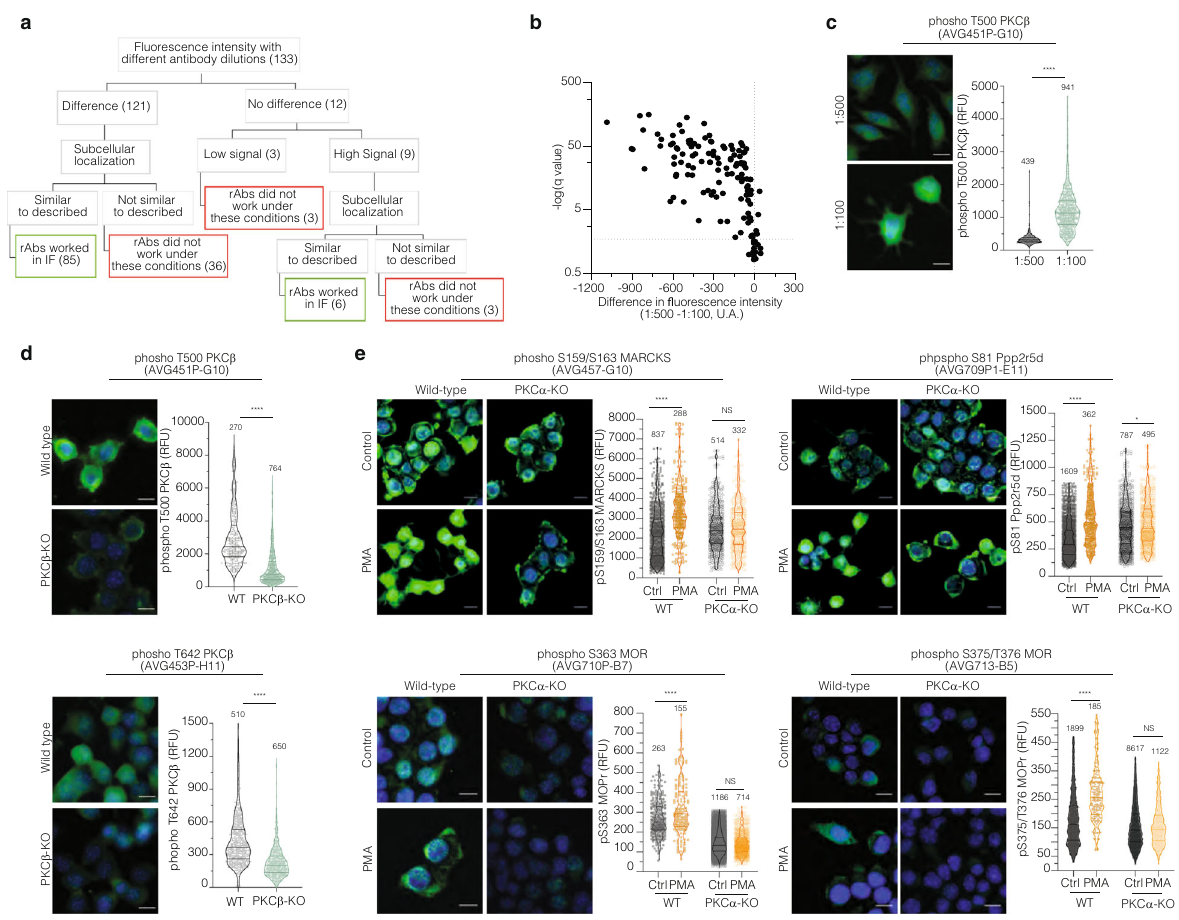
Fig. 3 High-throughput microscopy and genome editing as strategies to validate rAbs. a Schematic representation of the criteria used to validate the antibodies by high-throughput microscopy. The number of antibodies that matches each criteria step is represented in the box. b Volcano plot representing the fl uorescence intensity difference obtained from the comparison of two rAbs dilutions. Each dot represents one antibody tested. The x -axis describes the difference in the antibody fl uorescence intensity at two different dilutions (1:500 – 1:100), and the y -axis describes the log of the desired False Discovery Rate (Q). Using GraphPad prism, the two-stage step-up method of Benjamini et al. 13 was used to perform the analysis. The antibodies with Q higher than 2% were considered signi fi cant. c Representative image of Neuro2A cells probed with anti-phospho T500 PKC β (AVG451P-G10) antibody at a dilution of 1:500 and 1:100 (green), and DAPI (blue). Images were acquired using the InCell microscope (×40) and fl uorescence intensity measured by Cell Pro fi ler software. Representative images with the antibody staining in green and DAPI in blue are shown. Volcano plot, each dot represents one cell. Lines are mean ± SD of two experiments, number of counted cells are indicated. RFU indicates the integrated fl uorescence intensity units. **** p value < 0.0001; t -test. d Neuro2A and Neuro2A PKC β -KO cells were probed with anti-phospho T500 PKC β (AVG451P-G10) and anti-phospho T642 PKC β (AVG453P- H11) antibodies (green) and DAPI (blue). Images were acquired and analyzed as previously described. **** p value < 0.0001; t test. e Validation of phosphospeci fi c antibodies against PKC substrates. Neuro2A and Neuro2A PKC α -KO cells were probed with anti-phospho S159/S163 MARCKS (AVG 457-G10); anti-phospho pS81 Ppp2r5d (AVG709P1-E11) antibodies after PMA treatment (100 nM) for 30 min; anti-phospho S363 MOR (AVG710P- B7) antibody after PMA treatment (100 nM) for 60 min; anti-phospho S375/T376 MOR (AVG713-B5) antibody after PMA treatment (100 nM) for 30 s. Images were acquired and analyzed as previously described. **** p value < 0.0001; t